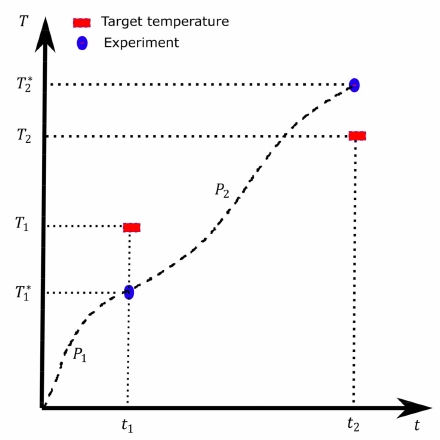
Figure 7. Schematics of one iteration (experiment) of the control assisted by the inverse